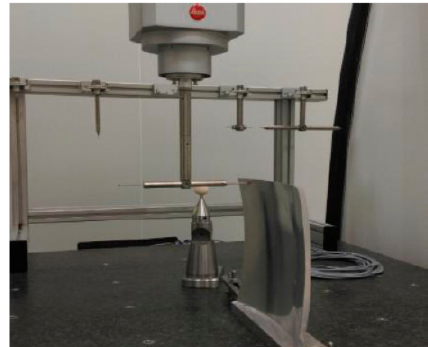
Figure 10. Equipment used in surface waviness measurement.